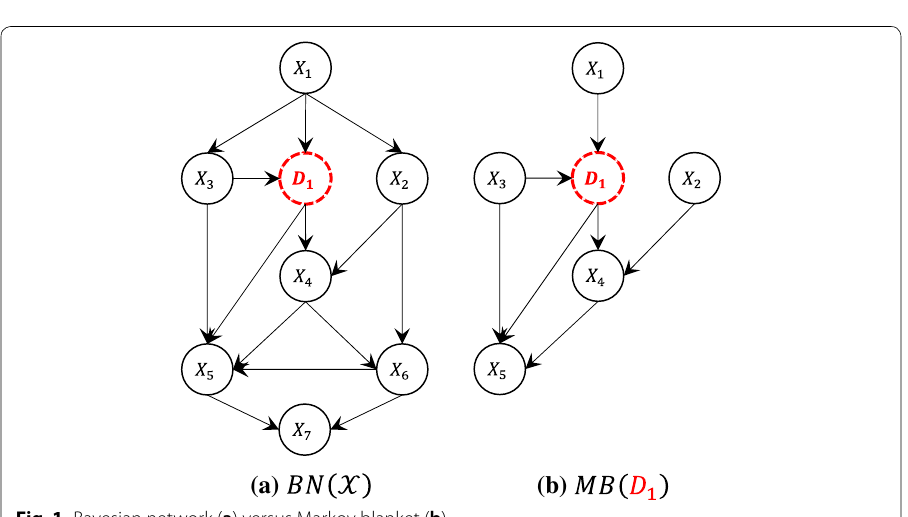
Fig. 1 Bayesian network ( a ) versus Markov blanket ( b